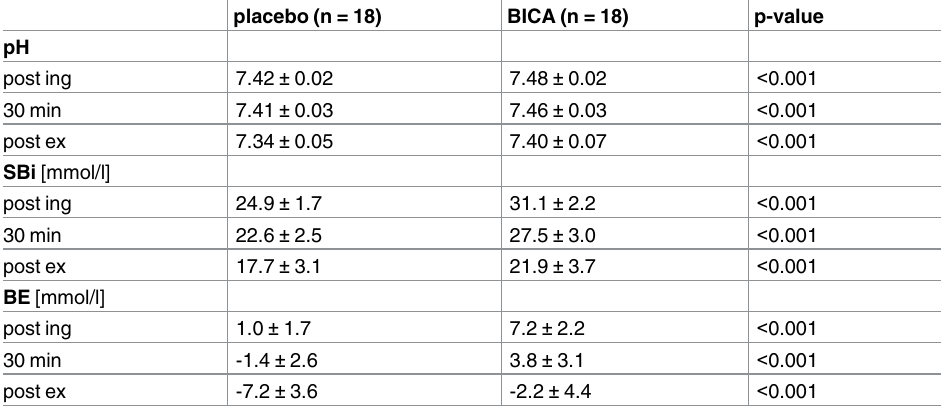
Table 1. Blood gas parameters during constant load test.